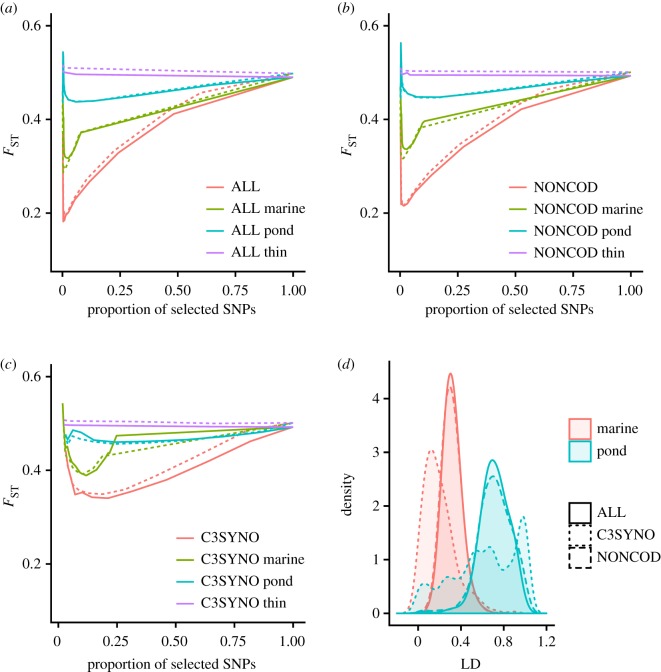
Effect of LD pruning on FST estimated from different datasets. Results are shown for (a) all SNPs (‘ALL' dataset), (b) non-coding/non-repeat sites (‘NONCOD' dataset) and (c) codon third position synonymous changes (‘C3SYNO' dataset). For each dataset, solid lines are colour coded to depict results obtained with the thinning approach (purple), or sliding window approach for all pooled populations (red), marine populations only (green) or pond populations only (blue). Dashed lines depict the same results after removing loci with MAF < 0.05. (d) The distribution of the average degree of linkage disequilibrium (LD) in marine and pond populations as estimated from non-overlapping 500 kb sliding windows across the genome.